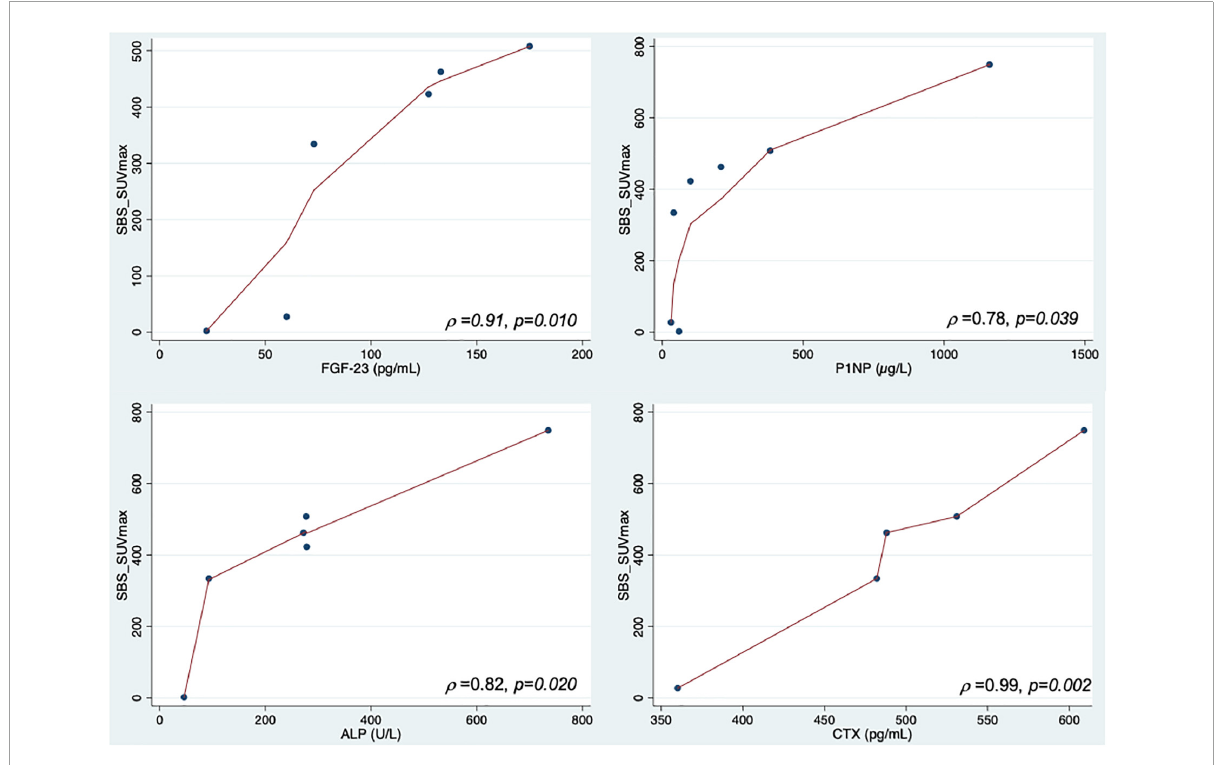
Scoliosis angle (0.33, –0.56–0.87, 0.472) (0.36, –0.52–0.88, 0.432) (0.58, –0.31–0.93, 0.168) (0.62, –0.25–0.94, 0.137) (0.63, –0.24–0.94, 0.133) CI,Confidenceinterval;SUV,Standarduptakevalue;SUVmax,maxiumStandardUptakeValue;SUVmean,meanStandardUptakeValue;SBS,SkeletalBurdenScore;SBS_SUVmax,SBS scoremultipliedbySUVmax;SBS_SUVmean,SBSscoremultipliedbySUVmean;FGF-23,Fibroblastgrowthfactor23;ALP,Alkalinephosphatase;P1NP,Procollagen1intactN-terminal propeptide;CTX,C-terminaltelopeptide.